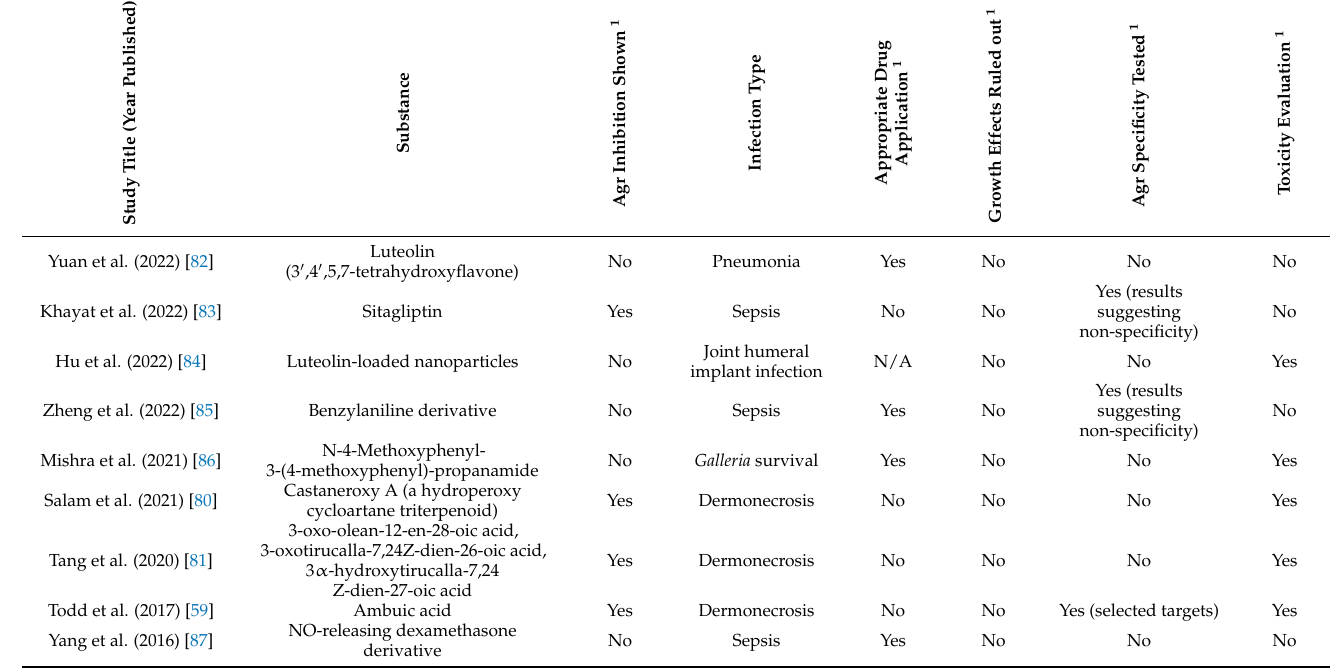
Table 3. In vivo studies with drugs targeting unknown or other targets in the Agr